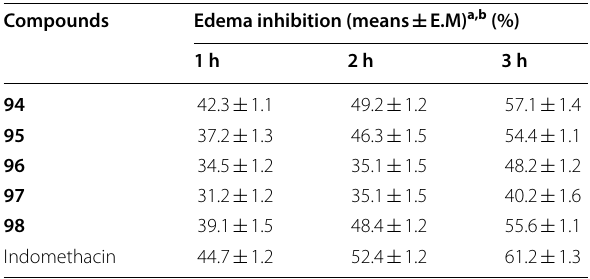
a Dose 5 mg/kg b.m (p.o.) b n 6